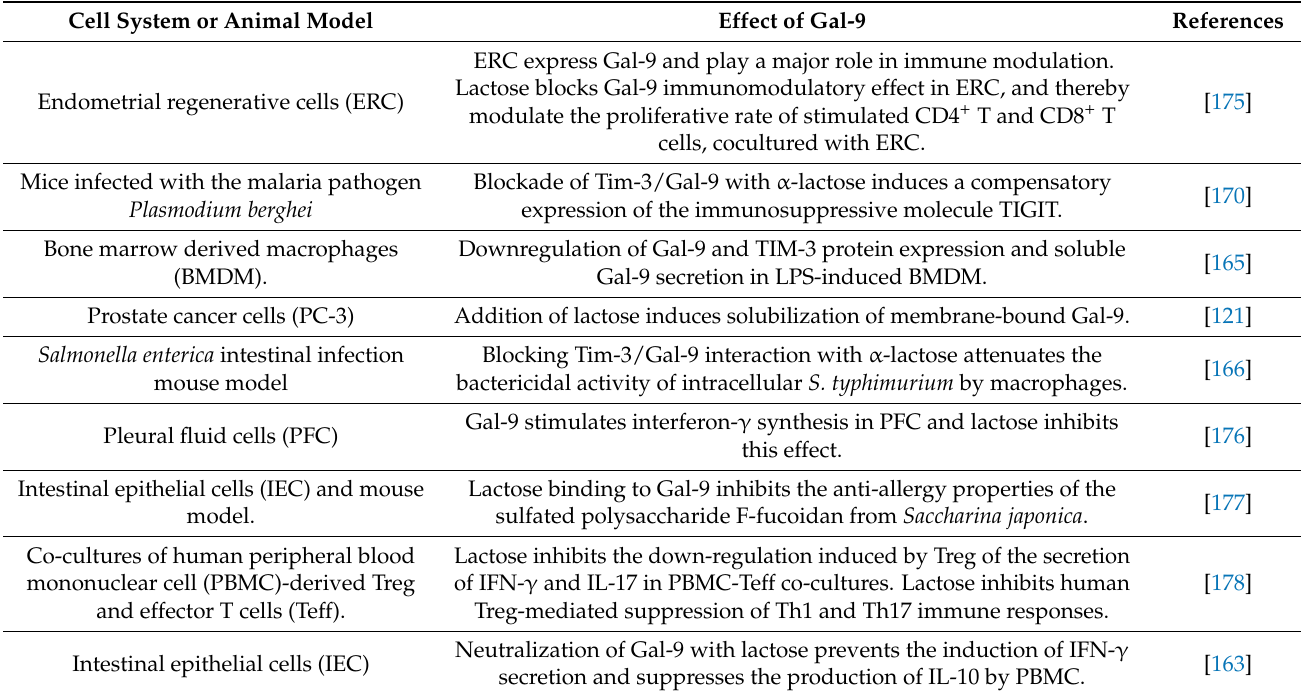
Table 3. Lactose binding to galectin-9 in different biological